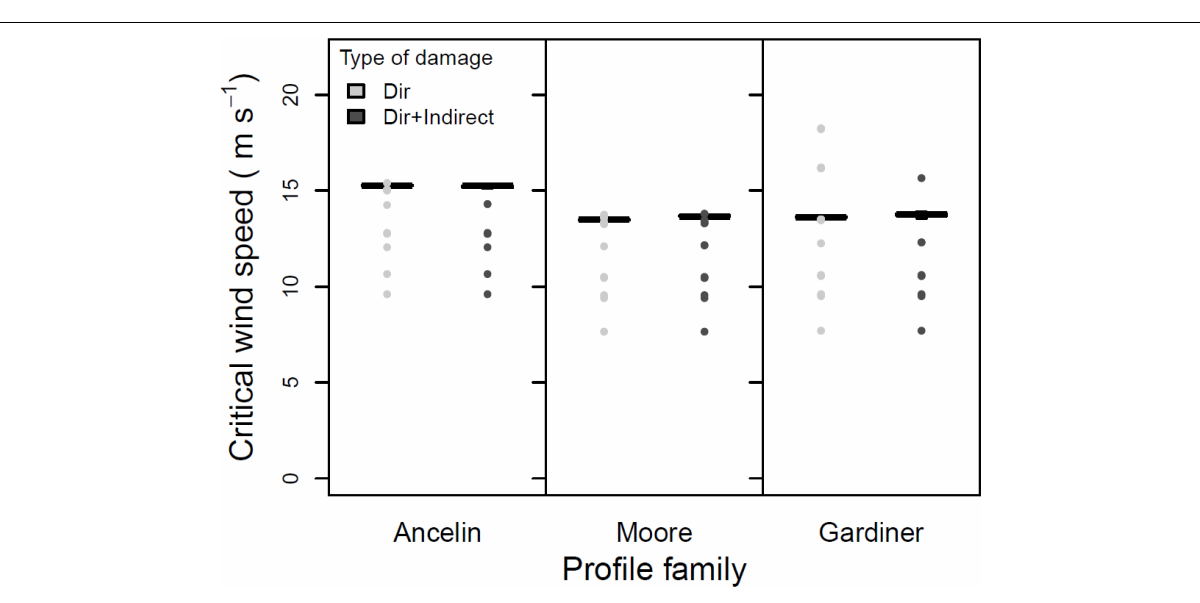
FIGURE 5 | Mean, 25 and 75% percentiles, 1.5 × interquartile range (whiskers), and outliers of critical wind speed (CWS) in m s − 1 , for three profile families, with and without indirect damage. Parameters constant across figure: stand orientation = A; alpha = 3.0 or LAI = 3.5; + neighbor support; +